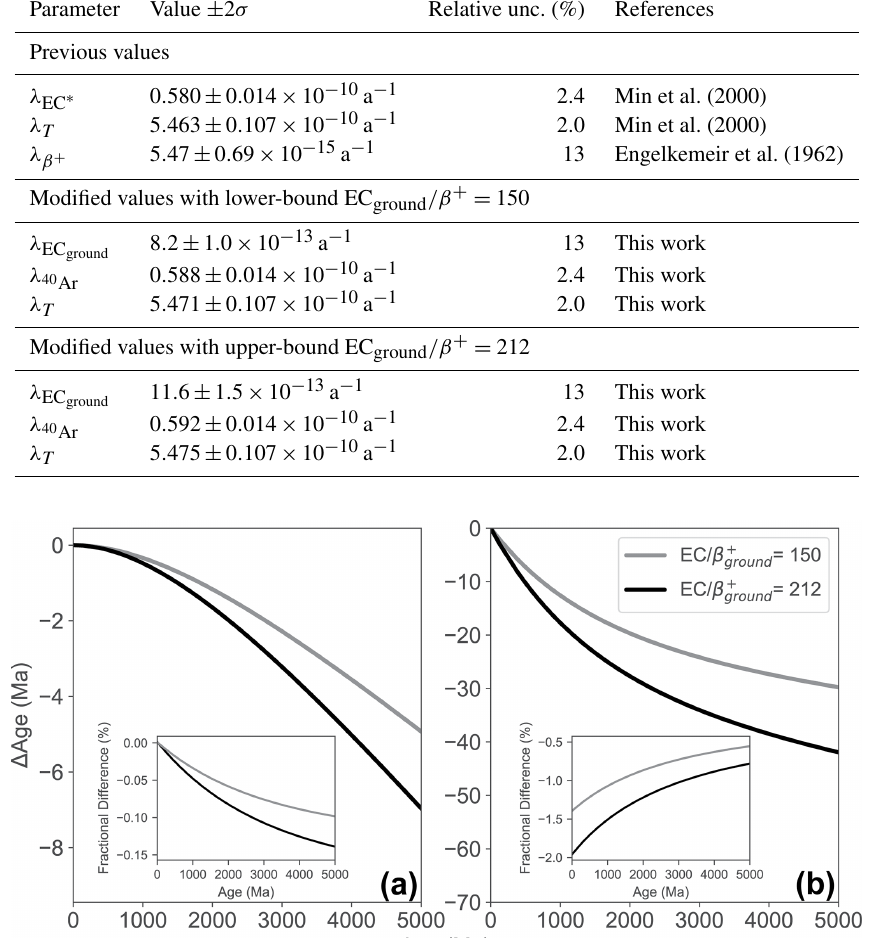
Figure 5. Change in age, (cid:49) age, is the age of a given sample with the decay mode to ground state included, subtracted from the age with the decay mode to ground state omitted. Panel (a) shows the change in age using the 40 Ar / 39 Ar equation with independently calibrated standards using both the lower bound (EC /β + = 150; grey) and upper bound (EC /β + = 212; black). Panel (b) shows the change in age using the K-Ar equation using both the lower bound (EC /β + = 150; grey) and upper bound (EC /β + = 212; black). Inset figures in each panel show the fractional differences in age by the inclusion of both the upper- and lower-bound EC /β + value. The larger difference in ages for the K-Ar system is due to the dependence on both the total decay constant and branching